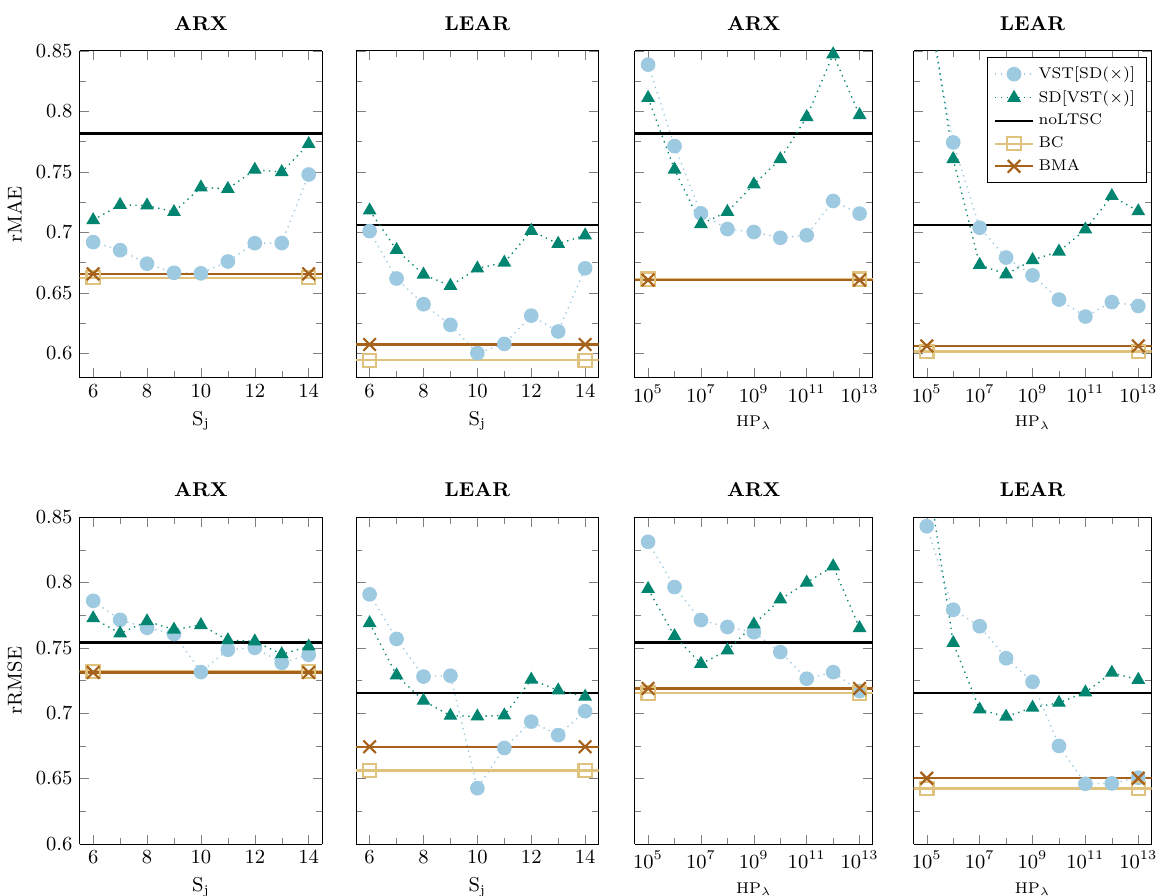
Figure 5. Relative mean absolute errors (rMAE; top row ) and relative root mean squared errors (rRMSE; bottom row ) for individual and combined forecasts obtained for the ARX ( left panels ) and LEAR ( right panels ) models and the NP dataset. Circles represent the performance of individual models where seasonal decomposition is executed first, then the VST is applied, while triangles are in the opposite order. Models without seasonal decomposition are indicated by the black solid line (labeled noLTSC), whereas the combined models by colored solid lines with markers at the